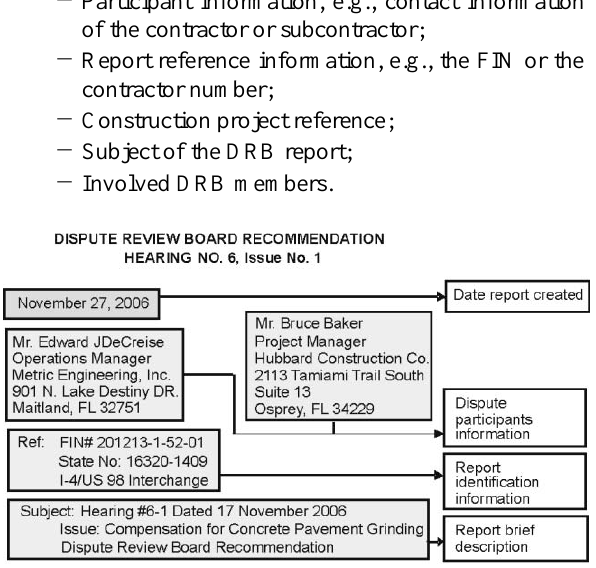
Fig. 5. Sample Basic Information of a DRB